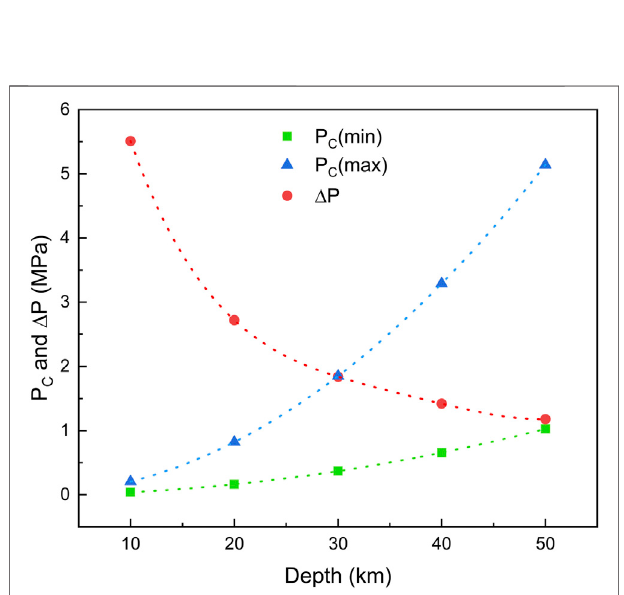
FIGURE 7 | Relationship between the pressure change caused by the magma solidi fi cation and the ultimate load of the overlying crust. P c (max) and P c (min) are obtained from the average maximum and minimum Young ’ s moduli of the main components of the crust (basalt and granite), respectively (Schultz, 1993; Yang et al.,